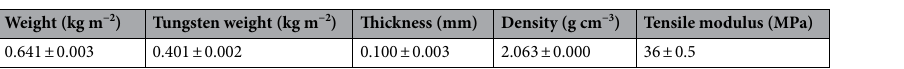
Table 2. Physical characteristics of the shielding paper.